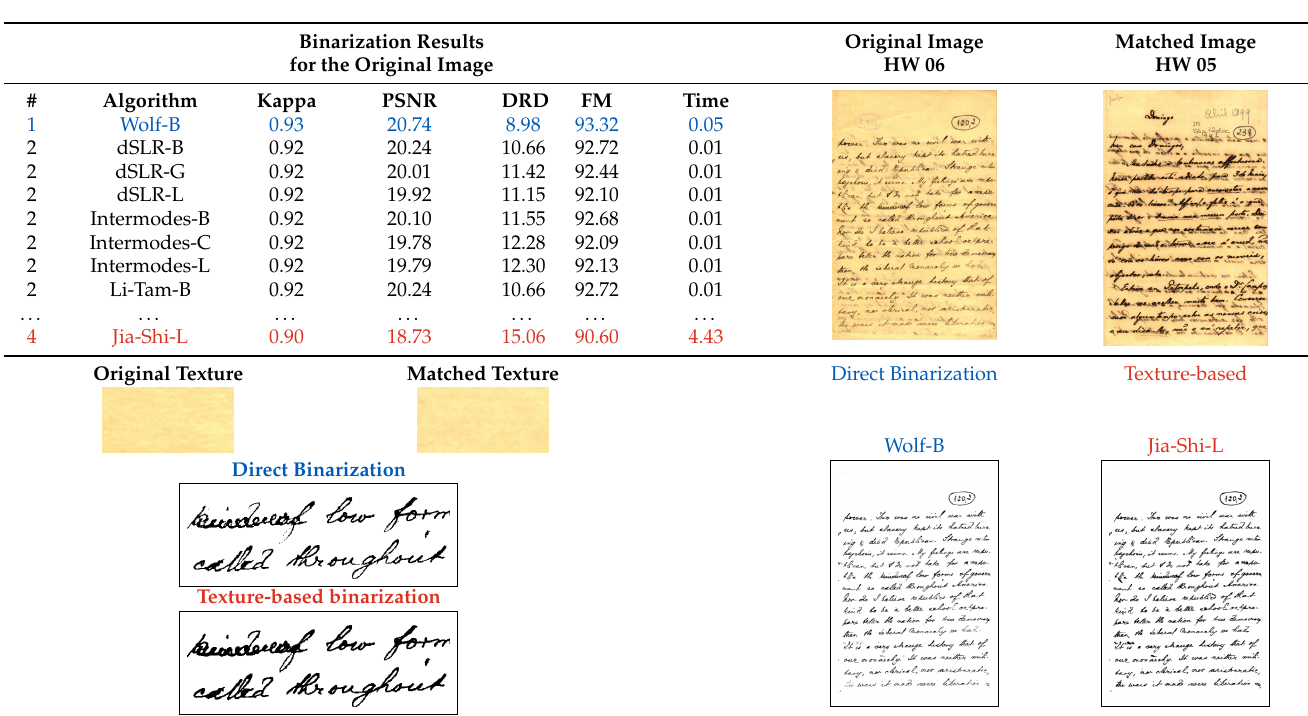
Table 9. Results for image matching with image HW